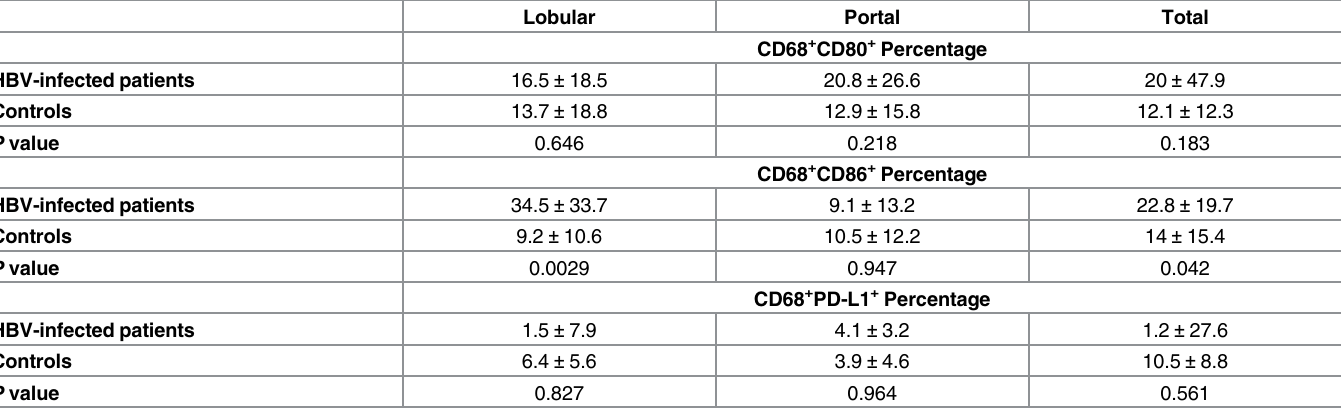
Table 3. Percentage of CD68 + cells, CD68 + CD80 + cells, CD68 + CD86 + cells and CD68 + PD-L1 + cells. The average of the percentages ± S.D. for each areas of the liver is represented as indicated. The p value indicates the significance of differences between HBV-infected and control groups.